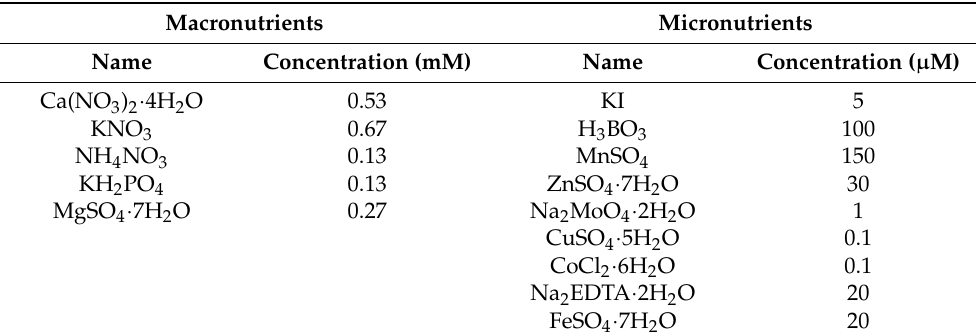
Table 2. Normal nitrogen nutrient solution formula. Macronutrients Micronutrients Name Concentration (mM) Name Concentration ( µ